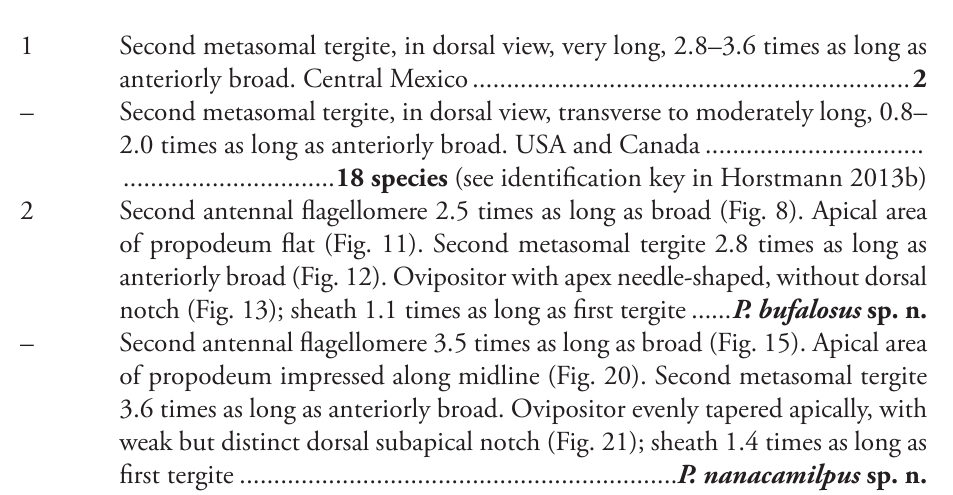
3.6 times as long as anteriorly broad. Ovipositor evenly tapered apically, with